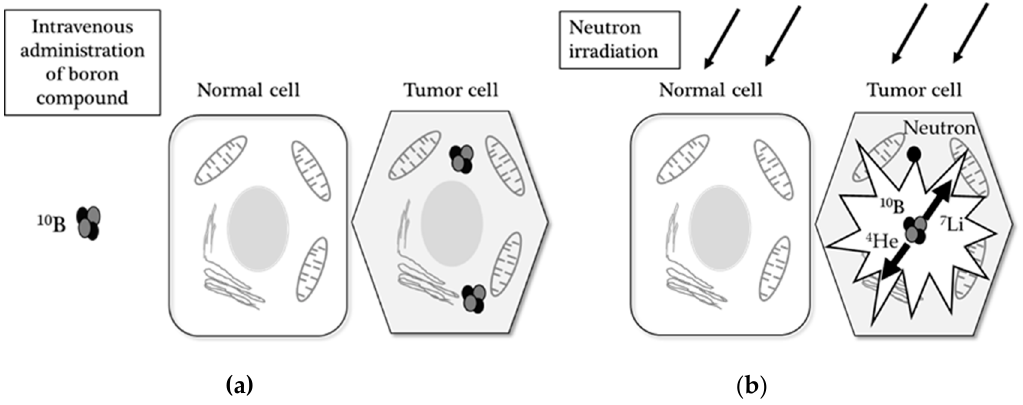
Figure 1. The principle of boron neutron capture therapy (BNCT): ( a ) a boron-10-labeled compound ( 10 B) is administered by intravenous injection and taken up specifically in the tumor cell (the left; hexagonal cells), but not in the normal cell (the right; squared cell); ( b ) following neutron irradiation, the absorption of a neutron converts 10 B to highly reactive alpha ( 4 He) and 7 Li particles, which results in selective tumor damage.